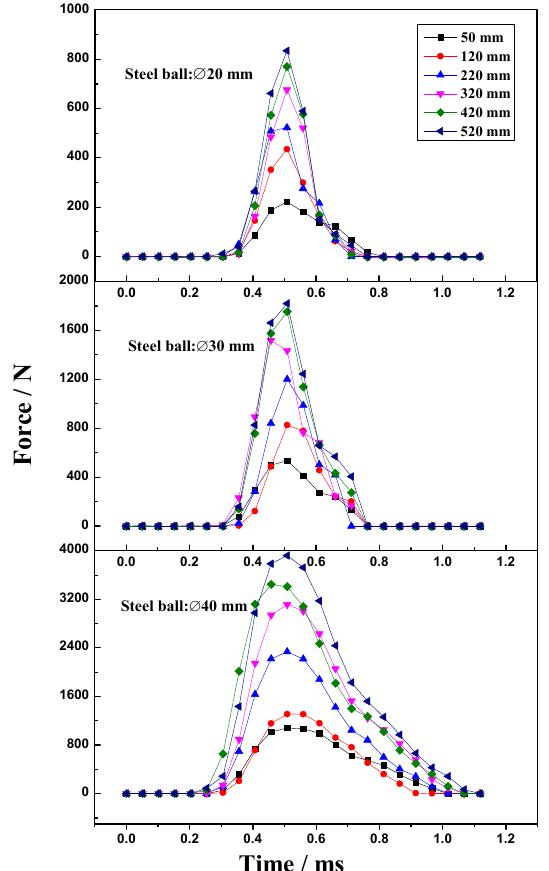
Figure 4. Impact force-time analysis curve for a steel ball with diameters of 20, 30 and 40 mm dropped from different heights.